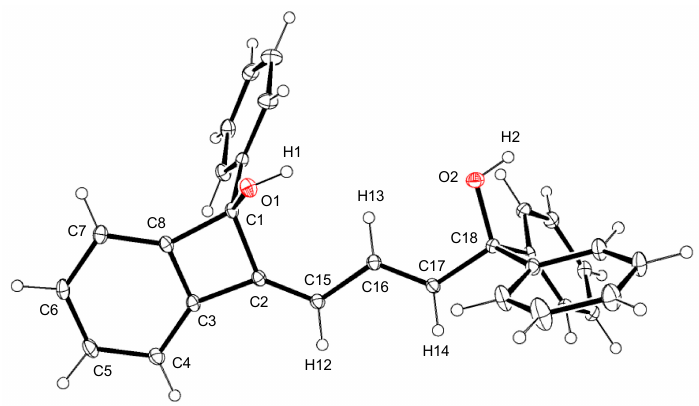
Figure 1. Crystal structure of 2a · 0.5acetone. The solvated molecule is omitted for clarity. Ellipsoids are drawn at the 30% probability level. Selected bond distances (Å) and angles (deg.): C1–C2, 1.565(2);